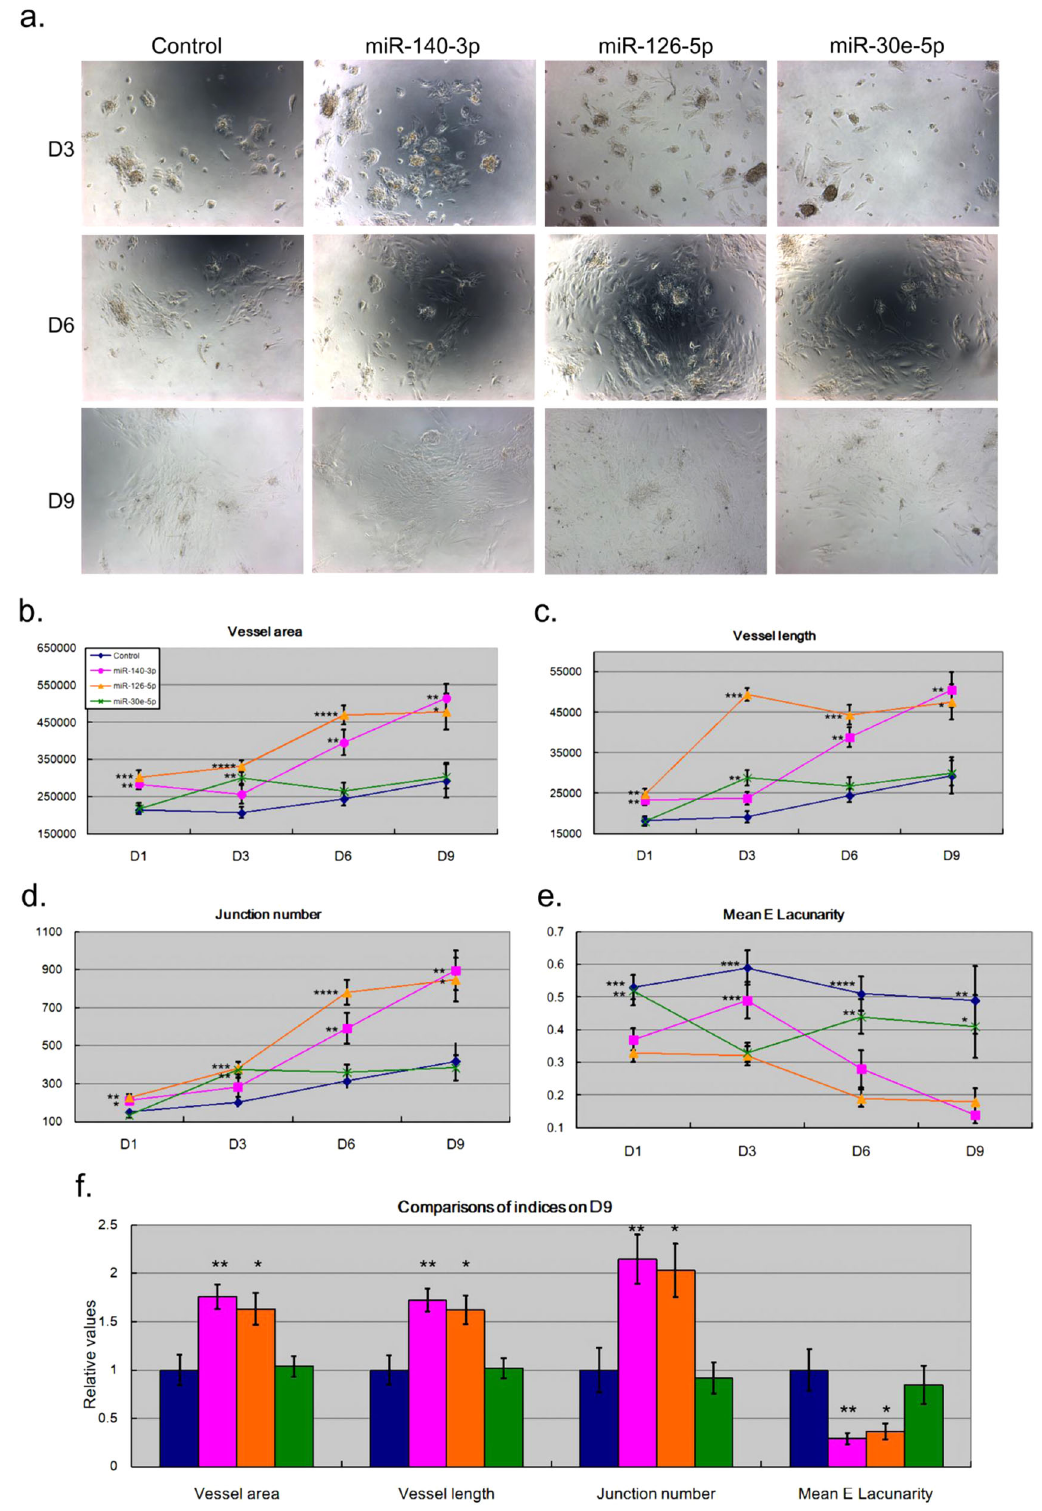
Fig. 3 Illustration and comparisons of the differentiation patterns of HCN-2 cells transfected with miRNA mimic. a HCN-2 cells were transfected with scrambled control mimic (control), hsa-miR-30e-5p mimic (miR-30e), hsa-miR-140-3p mimic (miR-140), or hsa-miR-126-5p mimic (miR-126) for 24 h. Then, they were seeded on new plates for monitoring and recording growth with a camera. Each transfection treatment had three independent wells, and three pictures were randomly taken from each well, resulting in 3*3 = 9 pictures. ( b – f ) We determined the differentiation patterns of HCN-2 cells in terms of different indices, including ( b ) vessel area, ( c ) vessel length, ( d ) junction number, and ( e ) mean lacunarity. The t -test p values were calculated by comparing the values of the control set on a speci fi c day. f For a systematic comparison, the values were normalized to the average values of the control set at day 9. *, **, *** and **** denote p value < 0.05, p value < 0.01, p value < 0.001, and p value < 0.0001,